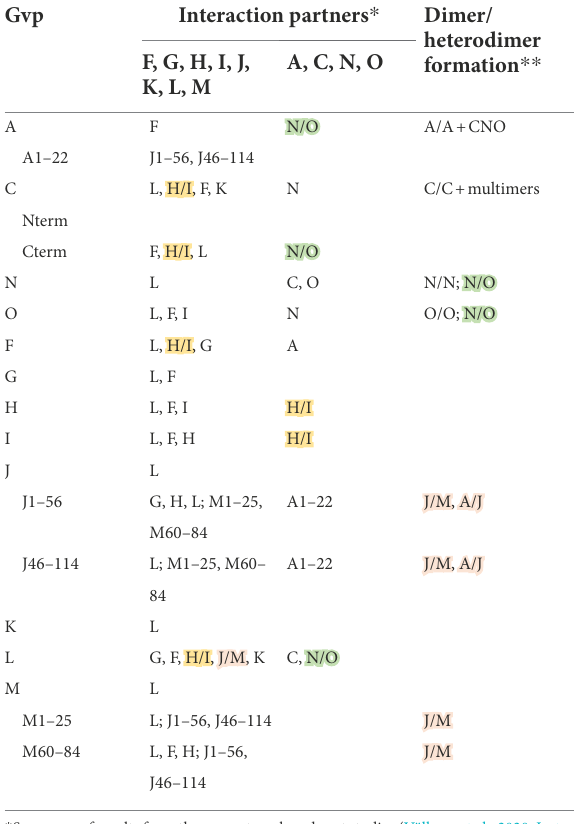
TABLE 2 Interaction of Gvp proteins as found by split-GFP